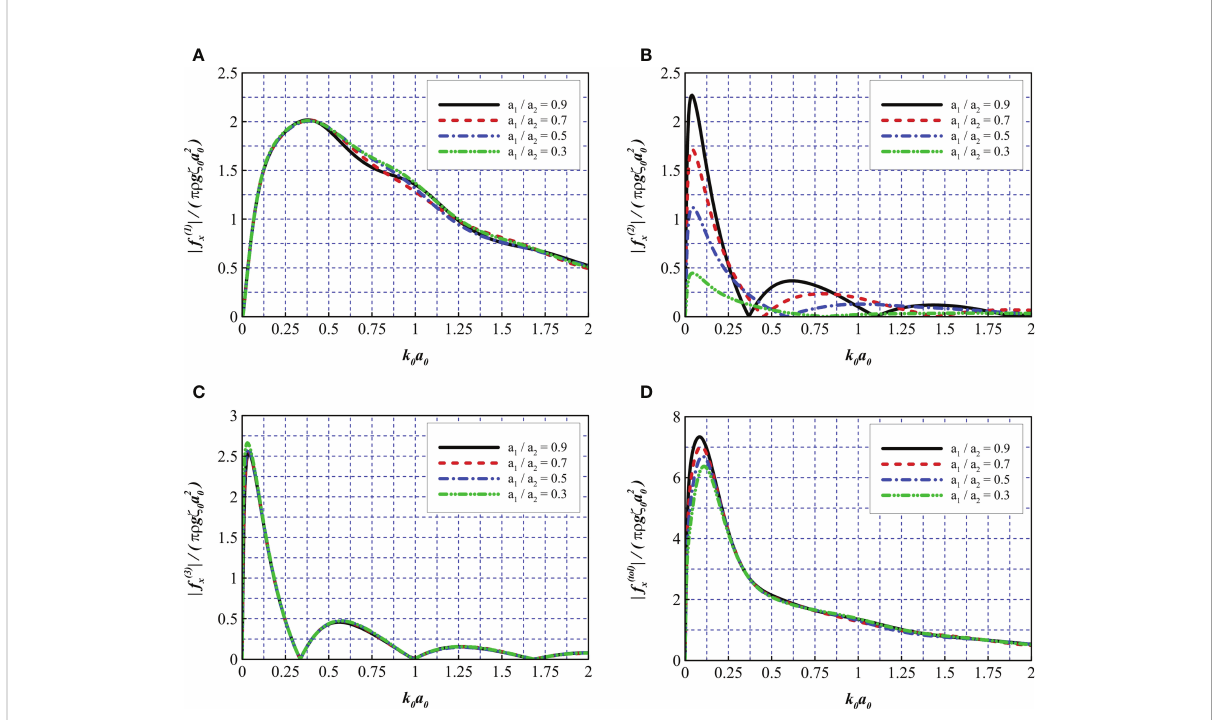
FIGURE 13 Comparison of wave force for different net spacing. (A) j f (1) x j = ( pr g z 0 a 2 0 ), (B) j f (2) x j = ( pr g z 0 a 2 0 ), (C) j f (3) x j = ( pr g z 0 a 2 0 ), and (D) j f (tol) x j = ( pr g z 0 a 2 0